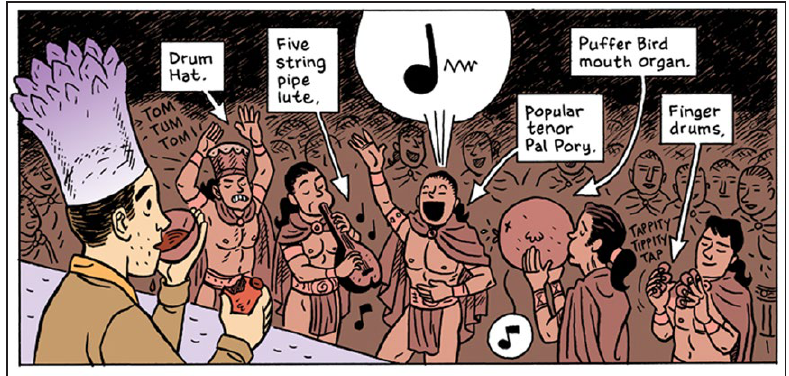
Figure 2: m usical note for melody ( Sam Zabel and the Magic Pen : 53) © Dylan